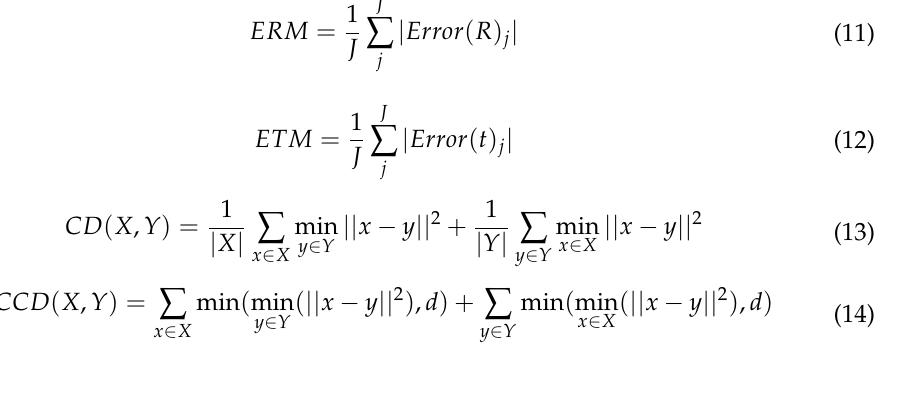
Figure 5. Experiment process.